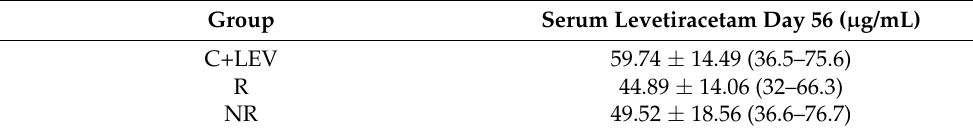
Table 3. Serum levetiracetam